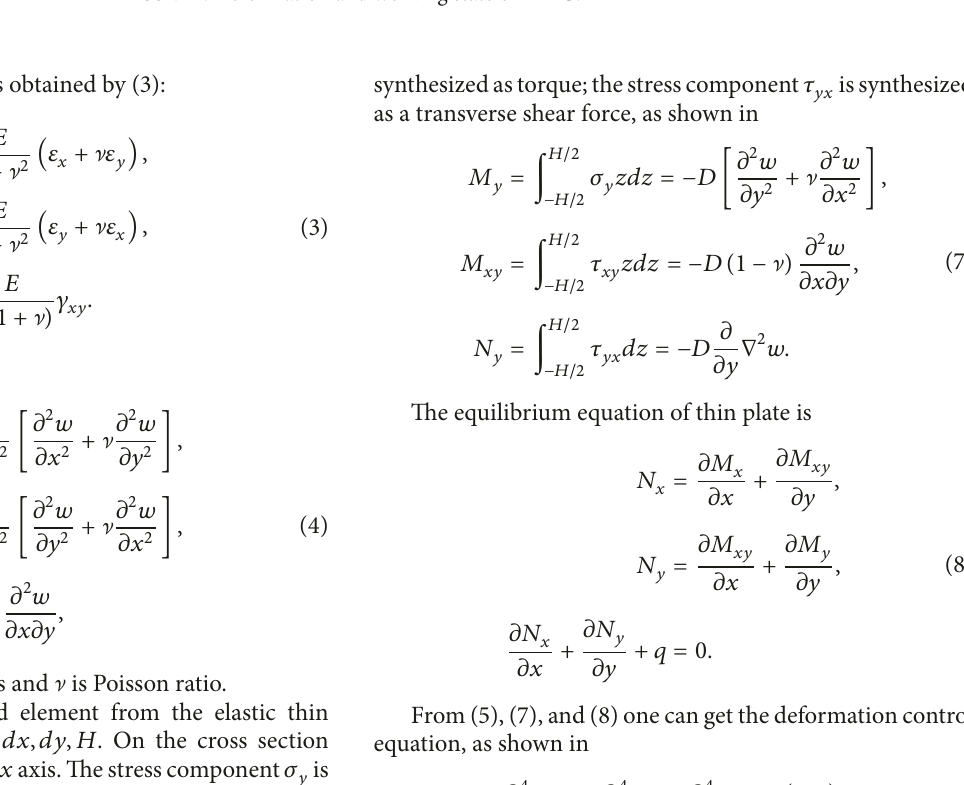
Figure 2: Deformation and working state of